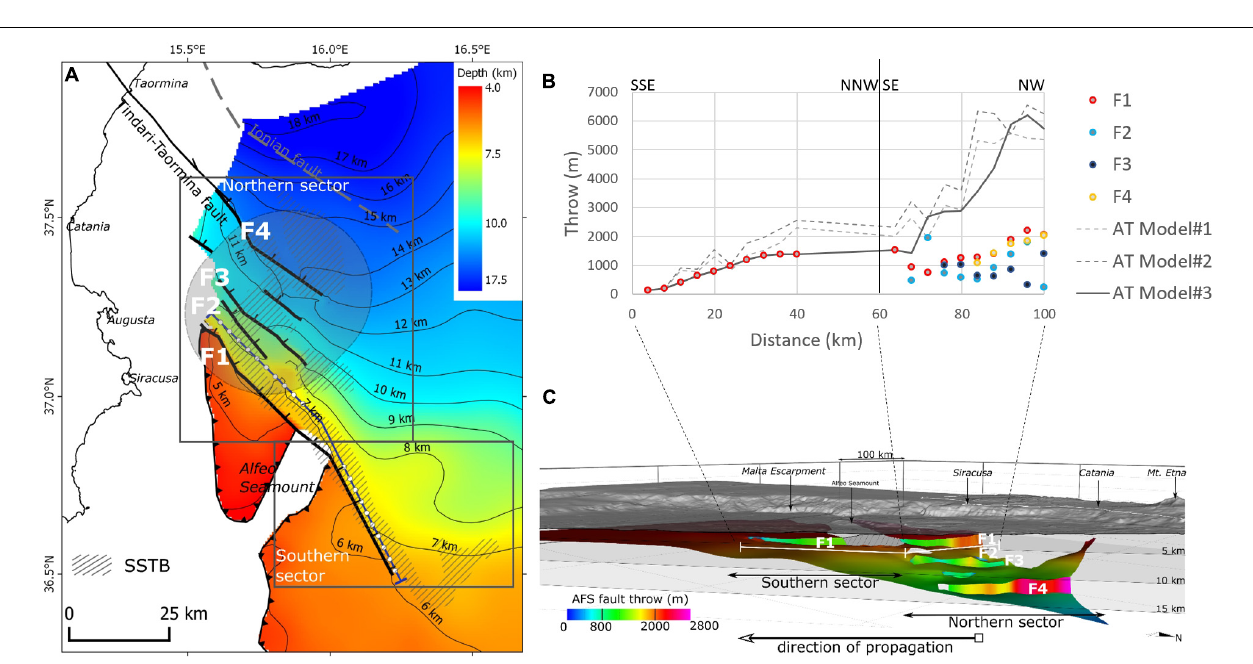
FIGURE 6 | Synthesis of the main structural elements within and around the Alfeo Fault System outlined onto the seismic profile shown in Figure 5A . Mechanical decoupling between the structural elements forming the Alfeo Fault System. The red-dashed area marks a layer immediately above the clearly offset subduction interface which seems to act as a barrier preventing the upward propagation of lower-plate faults and favoring the downward curvature of the upper-plate shallow faults. The red-shaded area indicates the occurrence of diffuse non-mappable shallow deformation on the AFS hanging wall.